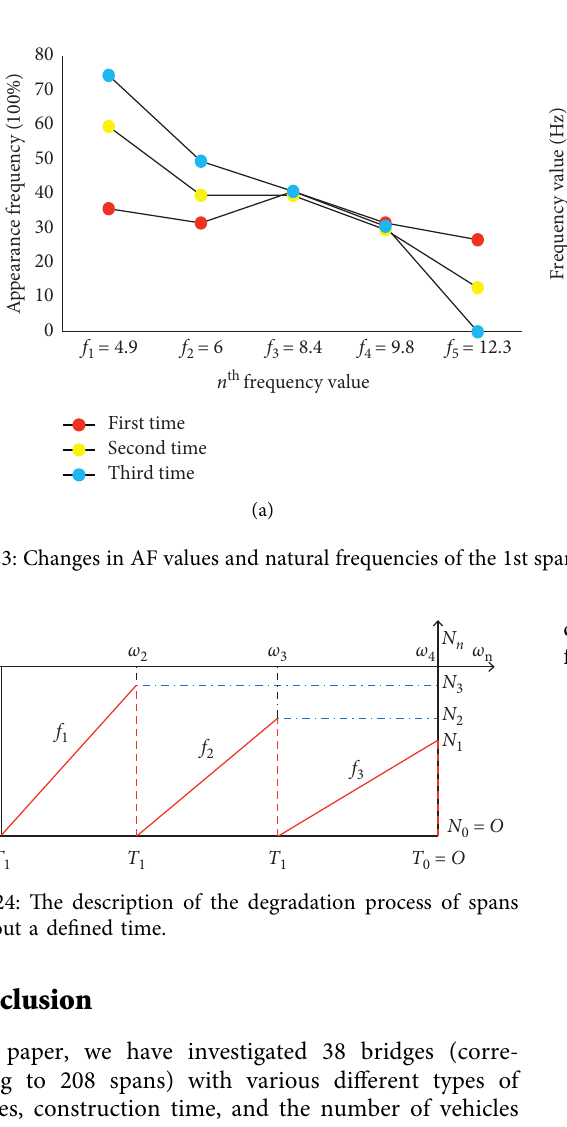
Figure 22: Changes in AF values of the 4th span of Thu Duc 2 flyover bridge through 3 different measurement periods.